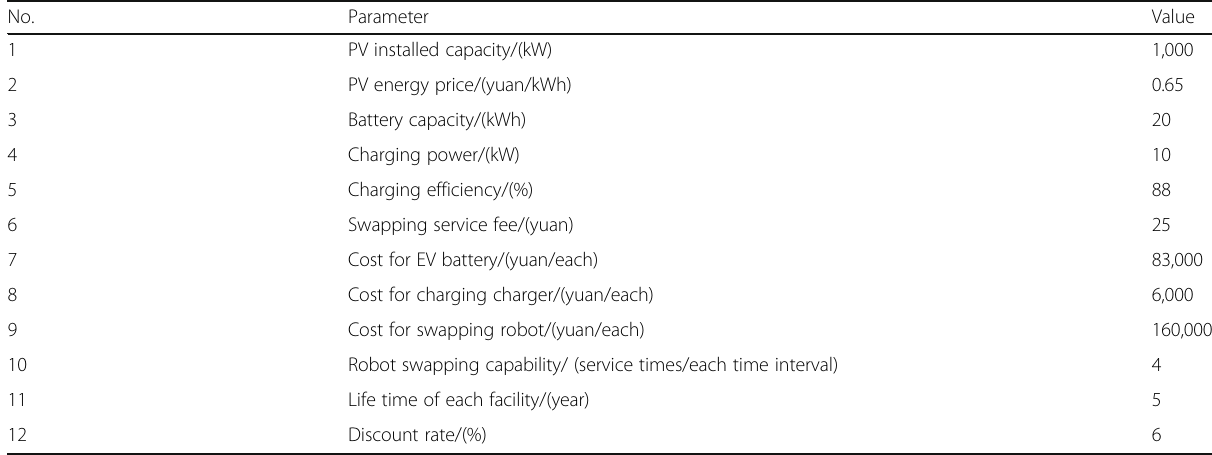
Table 1 Values of system parameters No.